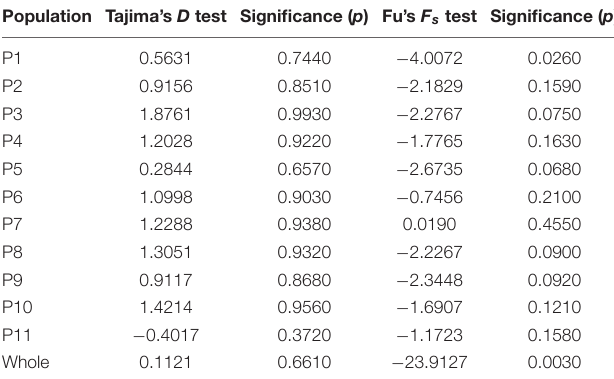
TABLE 6 | Neutrality test and the corresponding p -values for the populations of Aphis aurantii based on the concatenated cox1 and cytb